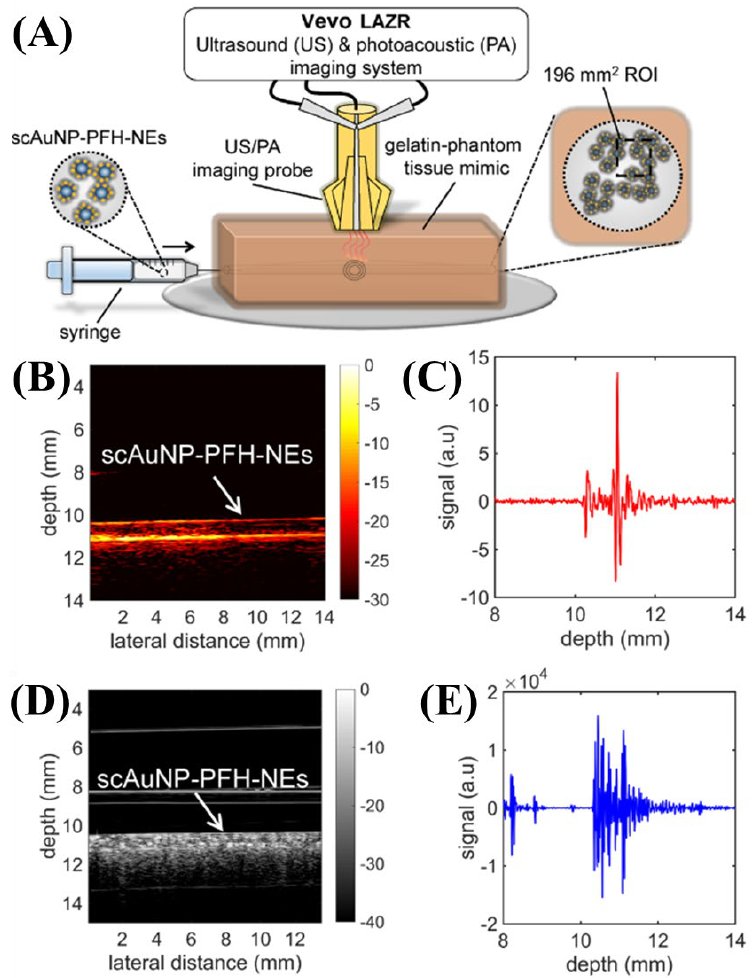
Figure 7. ( A ) Schematic of the Vevo LAZR system setup. ( B ) Photoacoustic and ( D ) ultrasound images of scAuNP-PFH-NEs. ( C ) Photoacoustic and ( E ) ultrasound signals. Reprinted from Fernandes et al., Langmuir, 2016, 32,42: 10870–10880 [25], with permission of the American Chemical